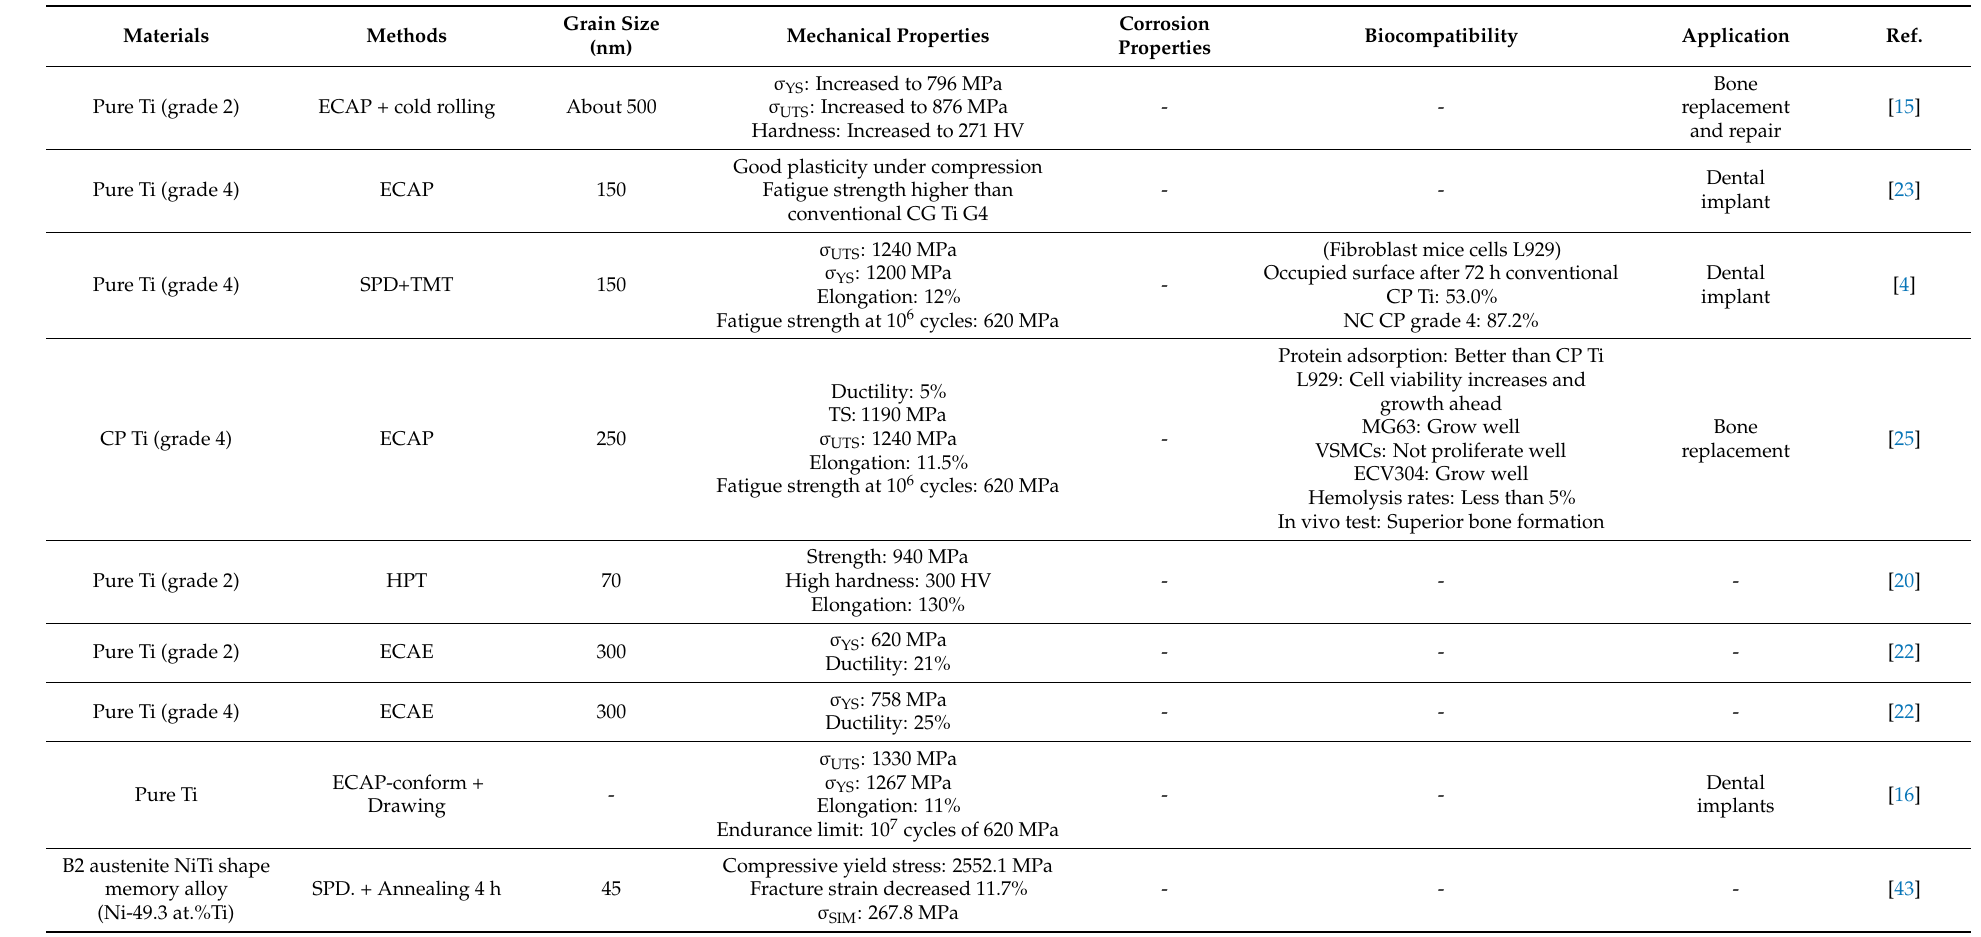
Table 1. Summary of bio-inert nanocrystalline metallic